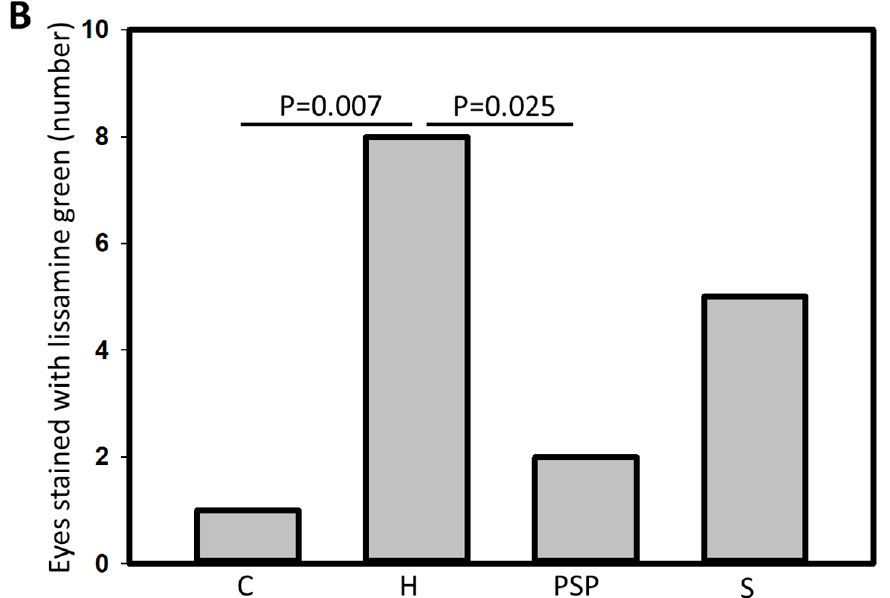
Figure 2. PSP reduced the erosion of ocular surface in HFD-treated rats. The animals were treated with a high-fat diet (HFD) alone or supplemented with PSP (5%) or atorvastatin (S) for 19 weeks. Before sacrifice, both eyes of each rat were stained with 1% ( w / w ) of lissamine green. Positive staining area indicated epithelial erosion was labeled with black arrow as shown in ( A ); the counts of positive signal were shown in ( B ). The chi-square test was conducted to analyze the results; p values were denoted to show the significant differences.